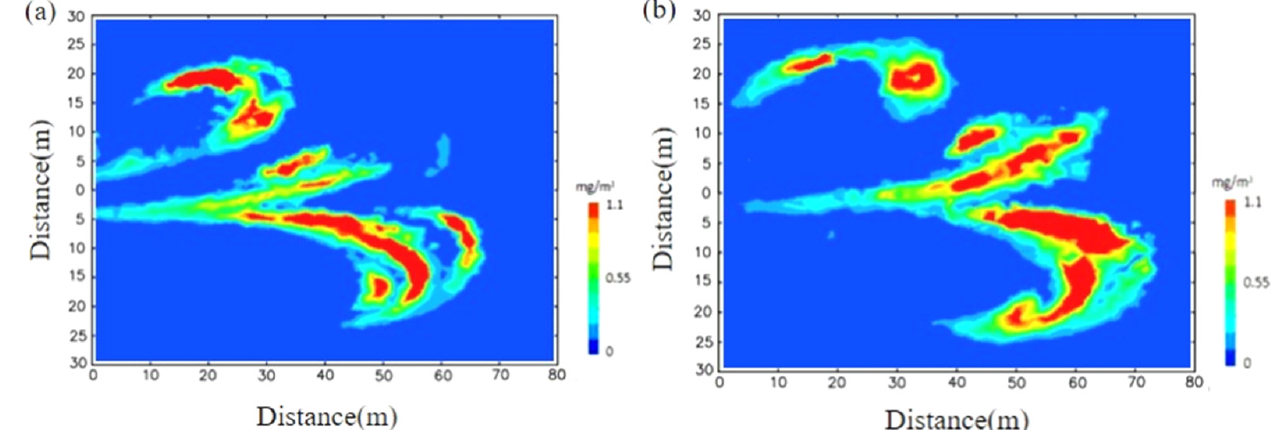
Figure 10. PM 10 concentration profiles at the horizontal direction at 1.5 m height with different wind directions by CFD technology: ( a ) northwest wind and ( b ) southeast wind (outside).